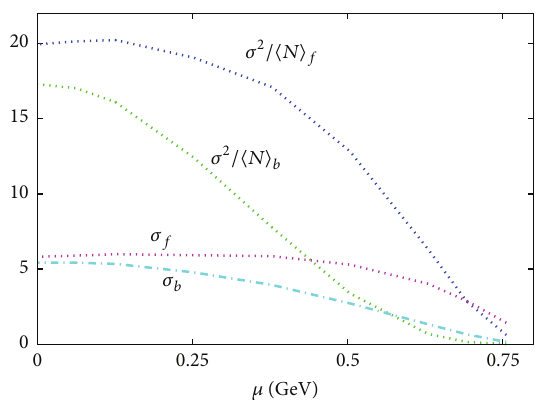
Figure 5: The ratio 𝜎 2 /⟨𝑁⟩ and 𝜎 are given depending on 𝜇 for boson and fermion